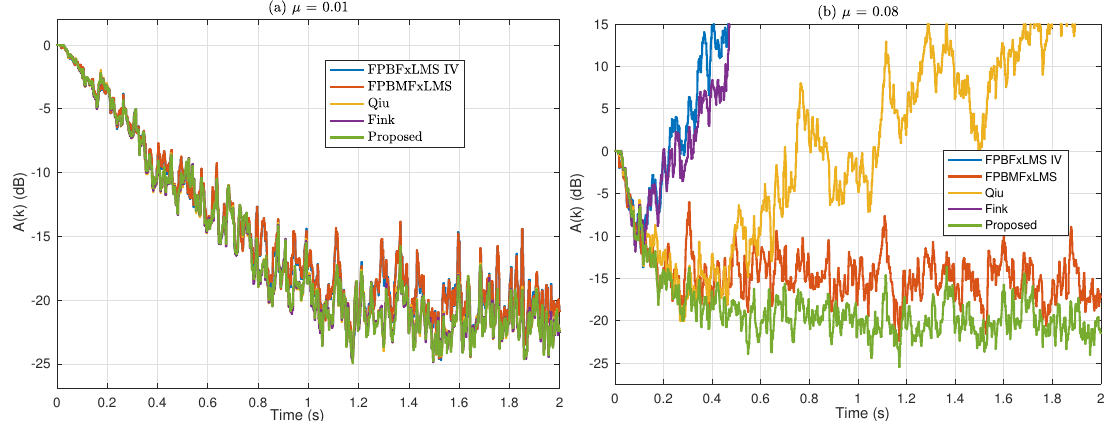
Figure 11. Algorithm stability of the traditional and modified structures. ( a ) µ = 0.01. ( b ) µ =